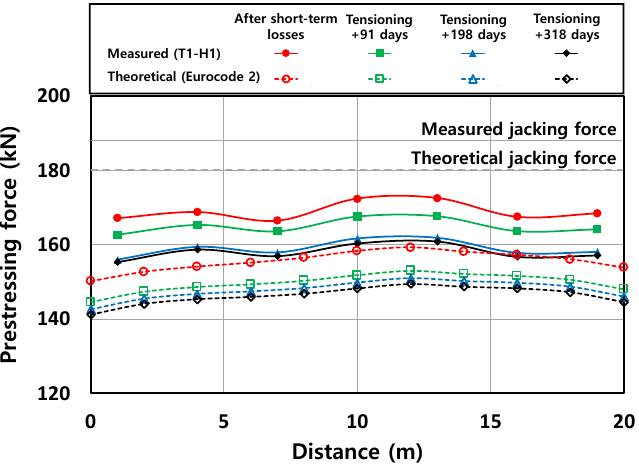
Figure 7. Distribution of PFs in the full-scale specimen (T1-H1).